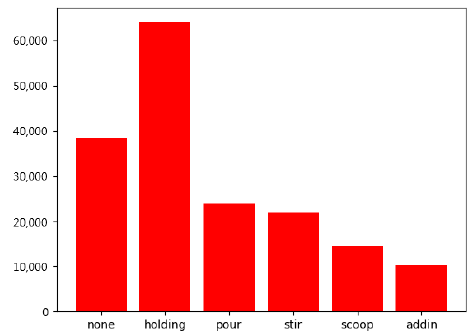
Figure 8. Uneven data in each action class.